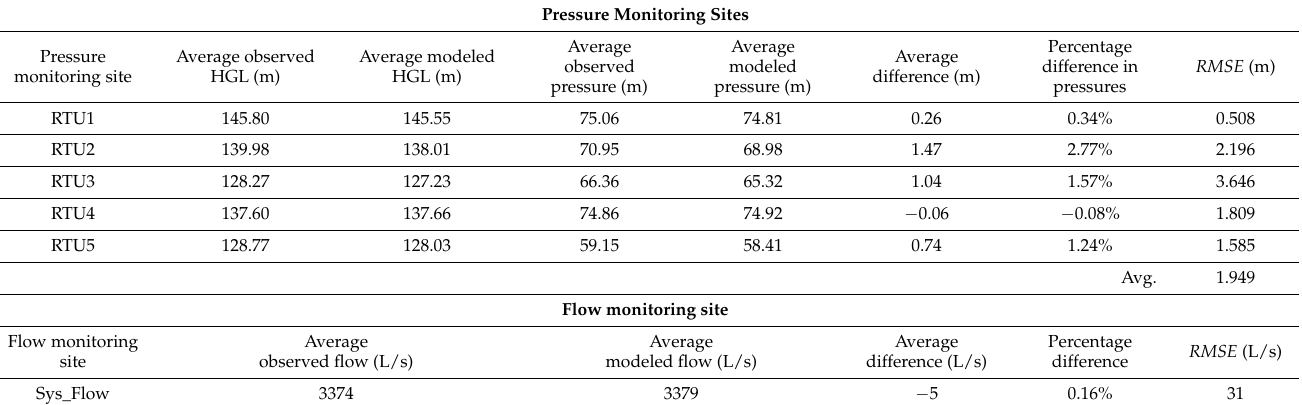
Table 6. Observed and simulated pressure data over the validation period at each monitoring